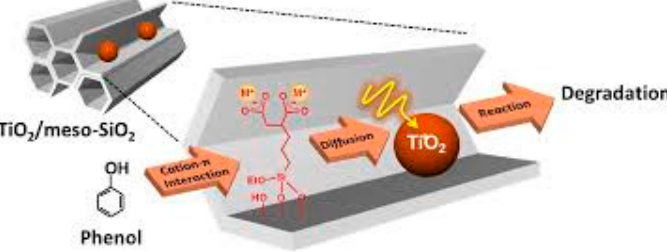
Figure 55. Schematic illustration of alkali metal cations-anchored mesoporous silica with catalytic centres. Reproduced with permission from [124]. Copyright 2017 WILEY-VCH Verlag GmbH & Co. KGaA, Weinheim.